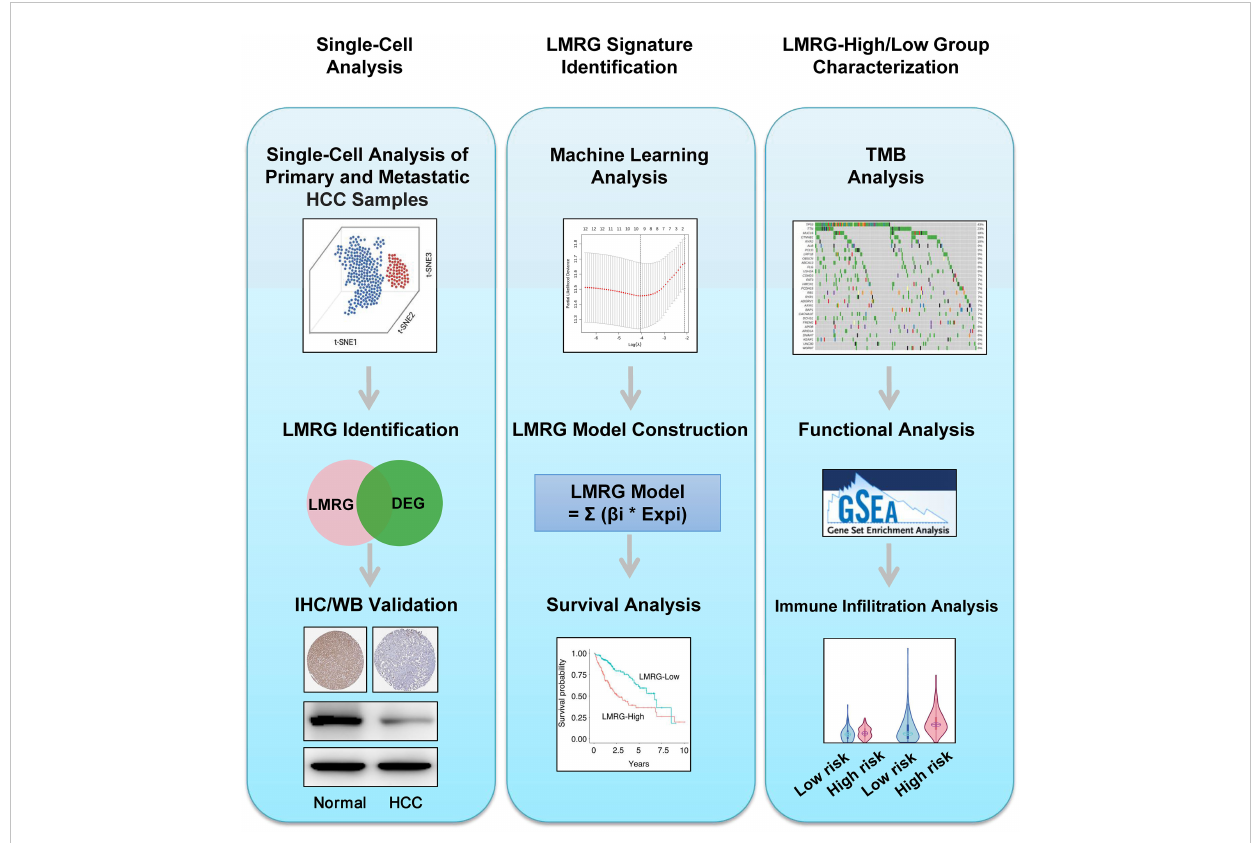
FIGURE 1 Work fl ow of this study. Step 1: Single-cell analysis. Step 2: LMRG signature identi fi cation. Step 3: LMRG-high and -low risk group